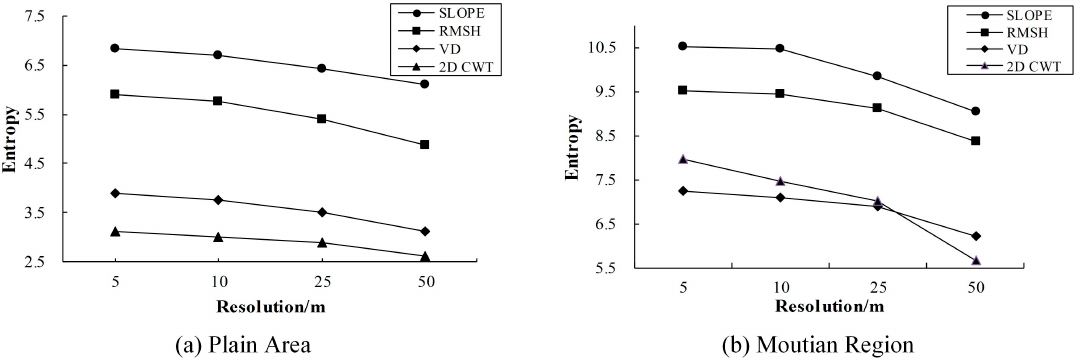
Figure 5. Entropy for different roughness values in different regions with different resolutions.